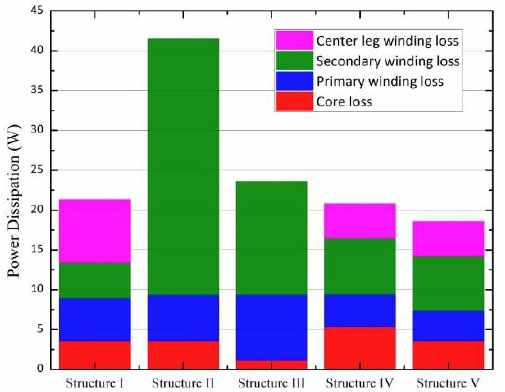
Figure 2. Comparison of the losses from five integrated magnetic components.